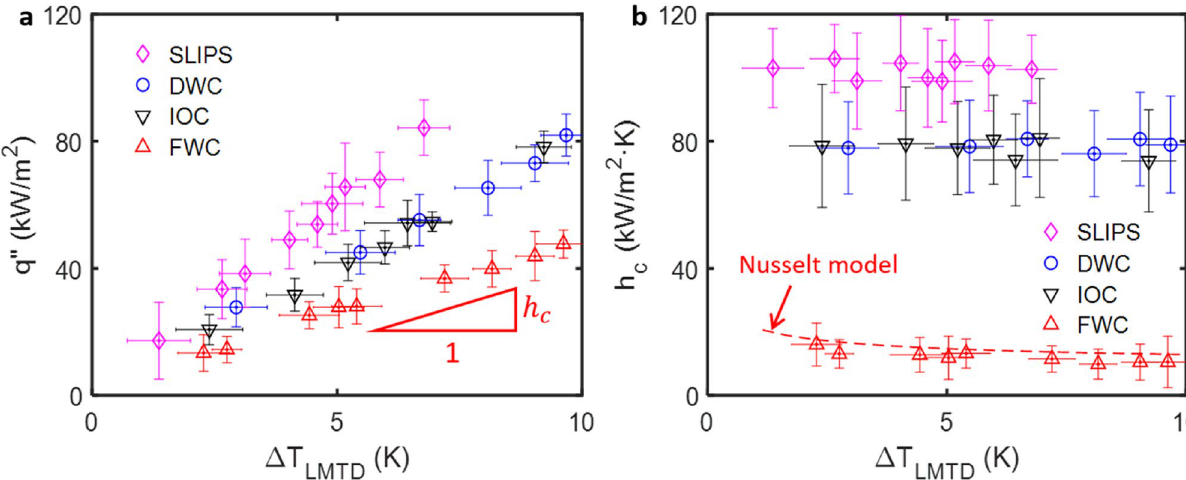
Figure 6. Heat transfer measurement. ( a ) Heat flux and ( b ) heat transfer coefficient as a function of logarithmic mean temperature difference. The slope in ( a ) is the heat transfer coefficient ( h c ). The heat transfer coefficient for DWC and IOC are nearly identical at ≈ 80 kW/m 2 K; a sevenfold increase from FWC (≈ 12 kW/m 2 K). The heat transfer coefficient increased further by ≈ 30% to ≈ 103 kW/m 2 K when the silica pores were impregnated with oil (SLIPS condensation). The classical Nusselt model for laminar film condensation is used to validate our heat transfer